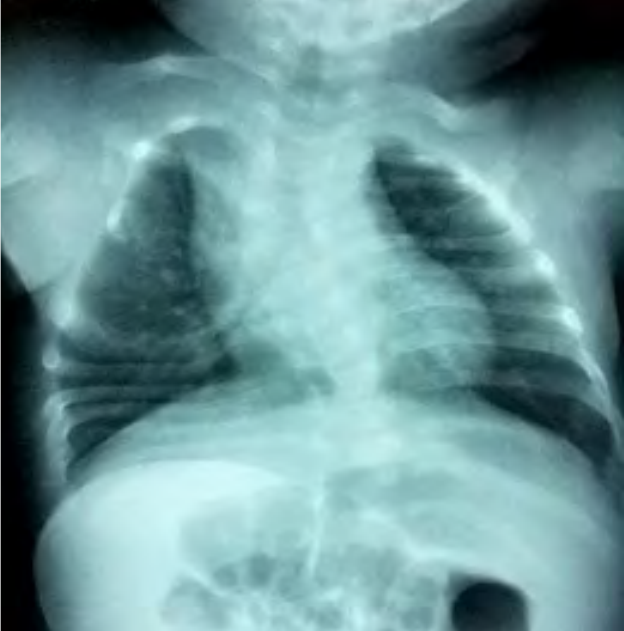
Figure 2 : Chest radiology showing deformation at the second, fourth, and fifth rib and the scoliosis.